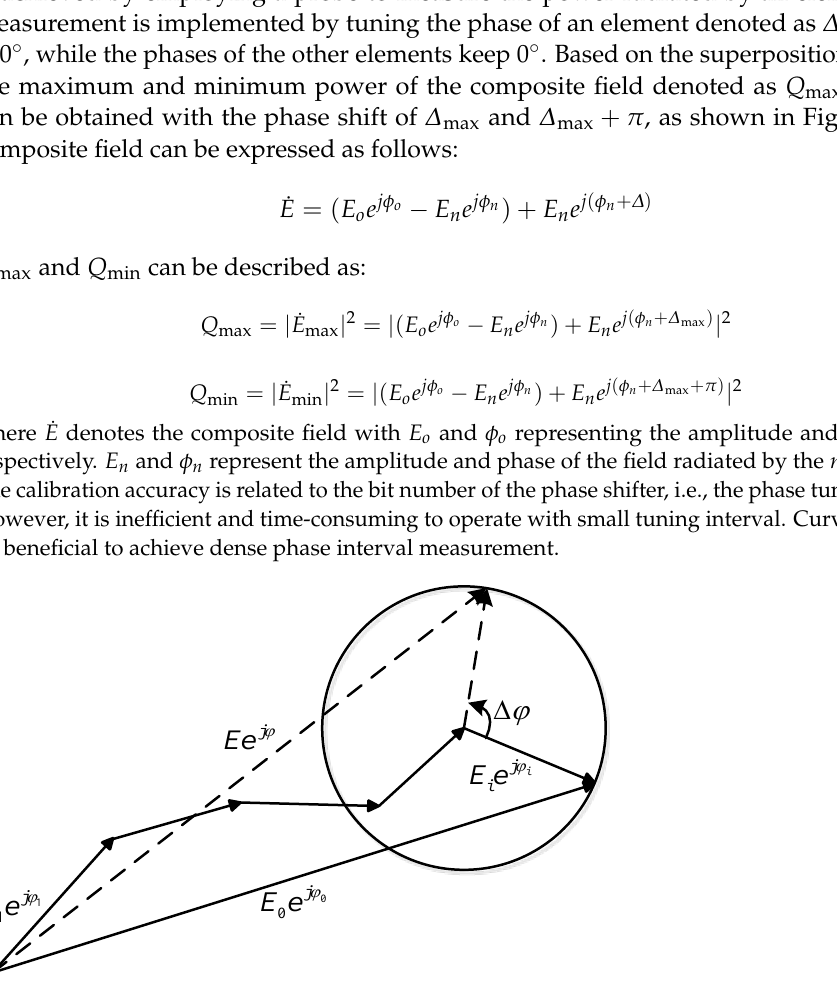
Figure 1. The composite of electric